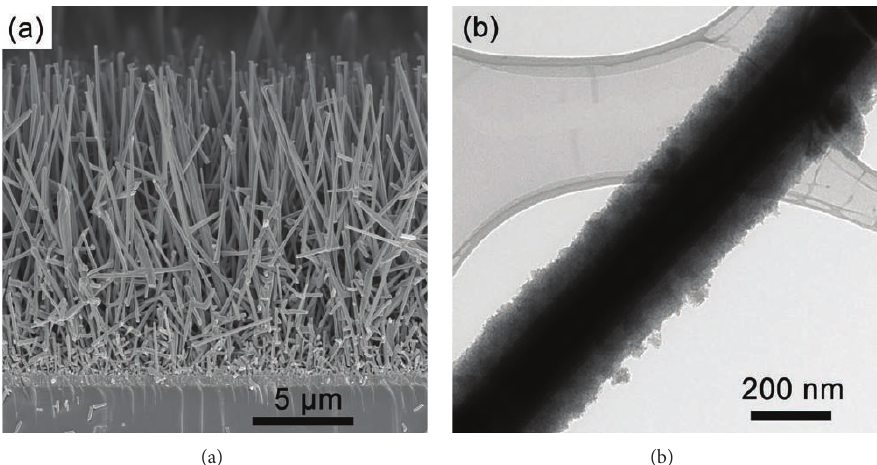
Figure 1: (a) SEM image of ITO nanowires grown by a thermal evaporation method and (b) TEM image of an ITO nanowire coated with TiO 2 by TiCl 4 treatment, forming an ITO-TiO 2 core-shell nanostructure.